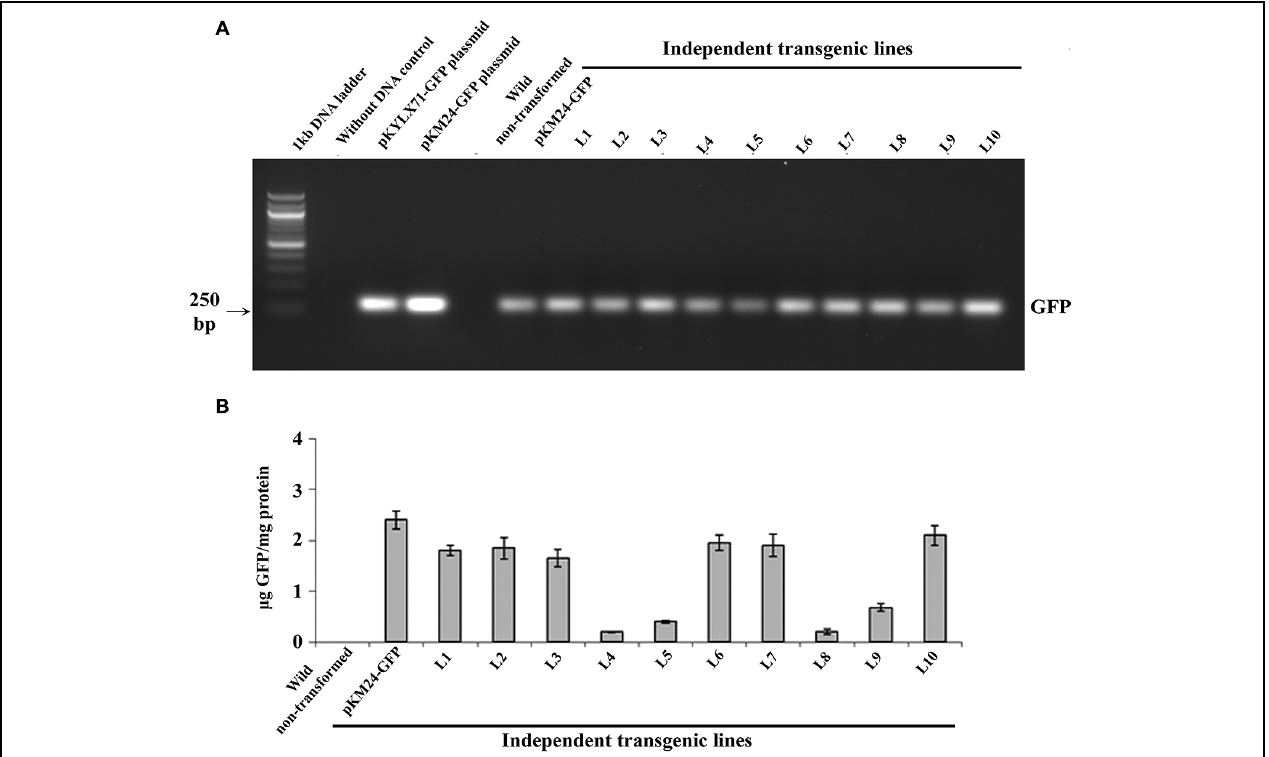
FIGURE 2 | Green Fluorescent Protein (GFP) analyses in transgenic tobacco lines. (A) PCR amplification of GFP (250 bp) using genomic DNA isolated from 10 independent transgenic plants (T 2 generation) expressing SAC-Par-4-GFP , vector control (VC) plant and wild-type plant; (B) The GFP protein concentration (expressed as μ g GFP/mg protein) was measured in total soluble protein of transgenic and wild-type plants using Turner Biosystems Luminometer at GFP-UV module. Error bars indicate the standard deviation of readings from five different plants of each line (three readings per